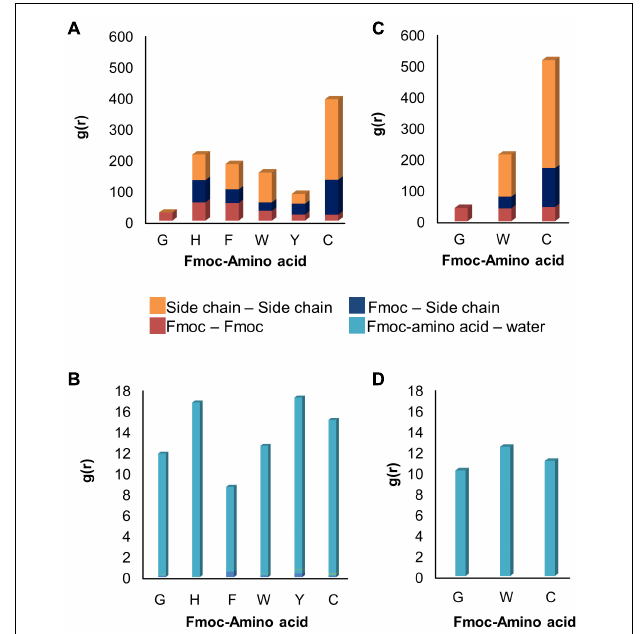
FIGURE 3 | RDF results showing the extent of (A) π − π and (B) hydrogen bond interactions in 1 ns long quench MD simulations, and (C) π − π and (D) hydrogen bond interactions in 10 ns long classical MD